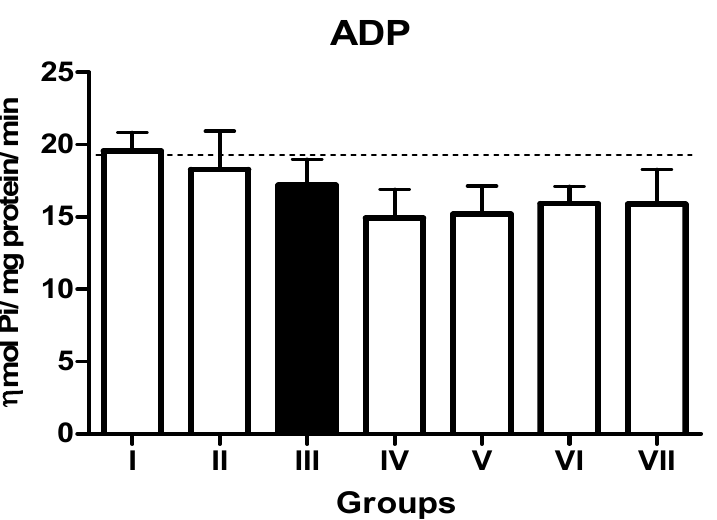
Figure 2. NTPDase (ADP as substrate) activity in platelets of L-NAME-stressed rats treated with tiger nut and walnut supplemented diets. Data are presented as mean ± SEM ( n = 10). The bars with various symbols are statistically different ( p < 0.05). * represents a significant difference from the control (I) group. # represents a significant difference from the ED (III) group (one-way ANOVA followed by post hoc Tukey, *, # denote p < 0.05; Key: Group I: Normal control placed on a basal diet; Group II: Positive control placed on a basal diet/L-NAME/Viagra (5 mg/kg/day); Group III: ED-induced group placed on a basal diet/L-NAME (40 mg/kg/day); Group IV: Processed TN supplemented diet (20%)/L-NAME; Group V: Raw TN supplemented diet (20%)/L-NAME (20%); Group VI: Processed WN supplemented diet (20%)/L-NAME; Group VII: Raw WN supplemented diet (20%)/L-NAME.